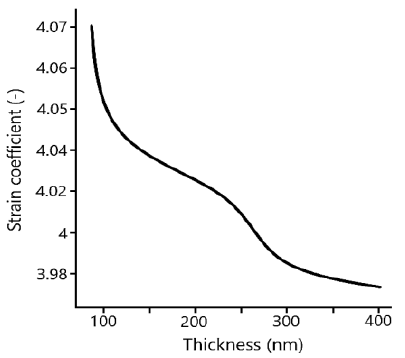
Figure 10. Strain coefficient dependence on thickness [28].